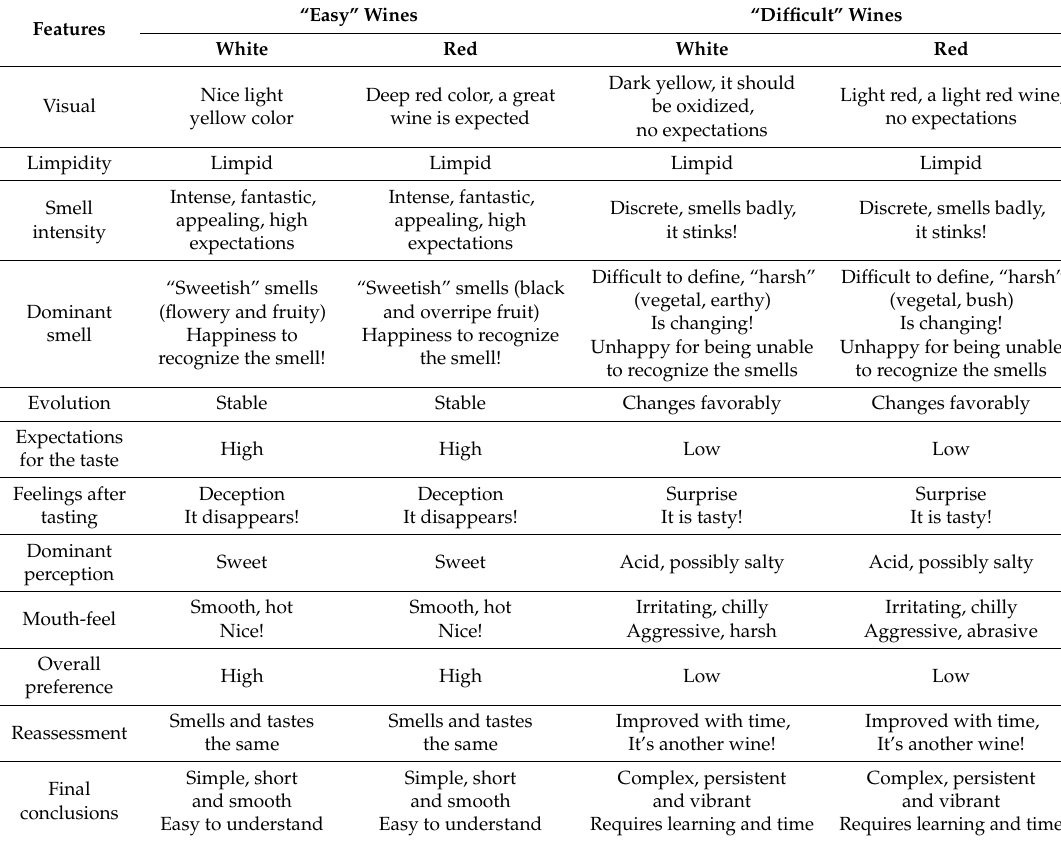
Table 1. Typical comments given by the tasting participants to the anchor wines representing the two opposite styles used in the first training session of the emotional